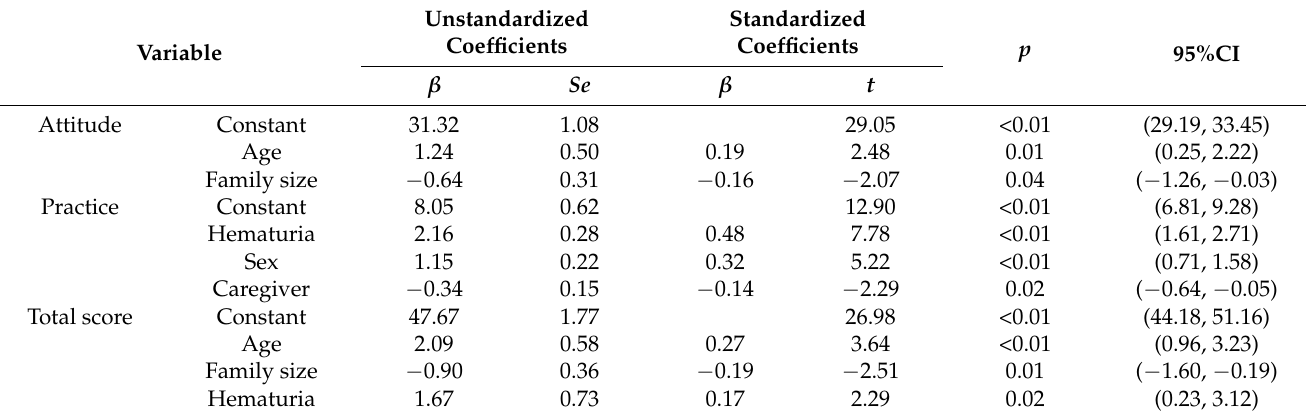
Table 4. Multivariate analysis of factors associated with schistosomiasis